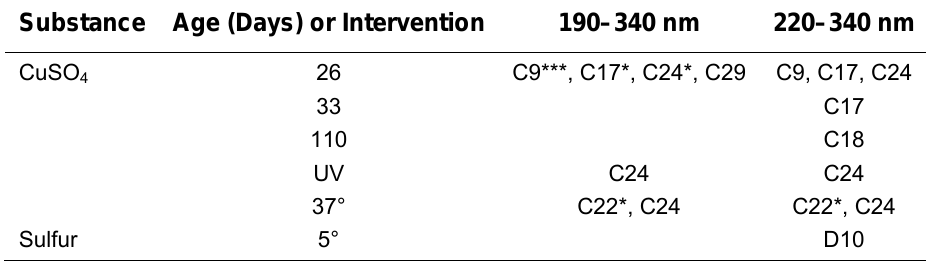
and S Compared to the Controls by a t-Test 4 8